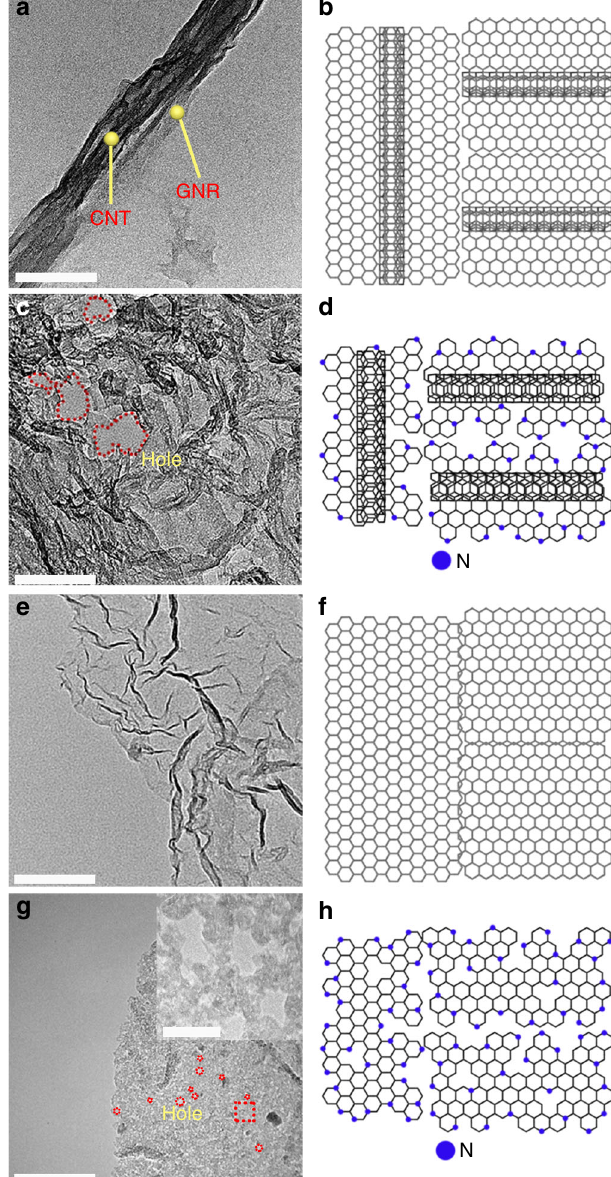
Fig. 2 Transmission electron microscopy images and schematic